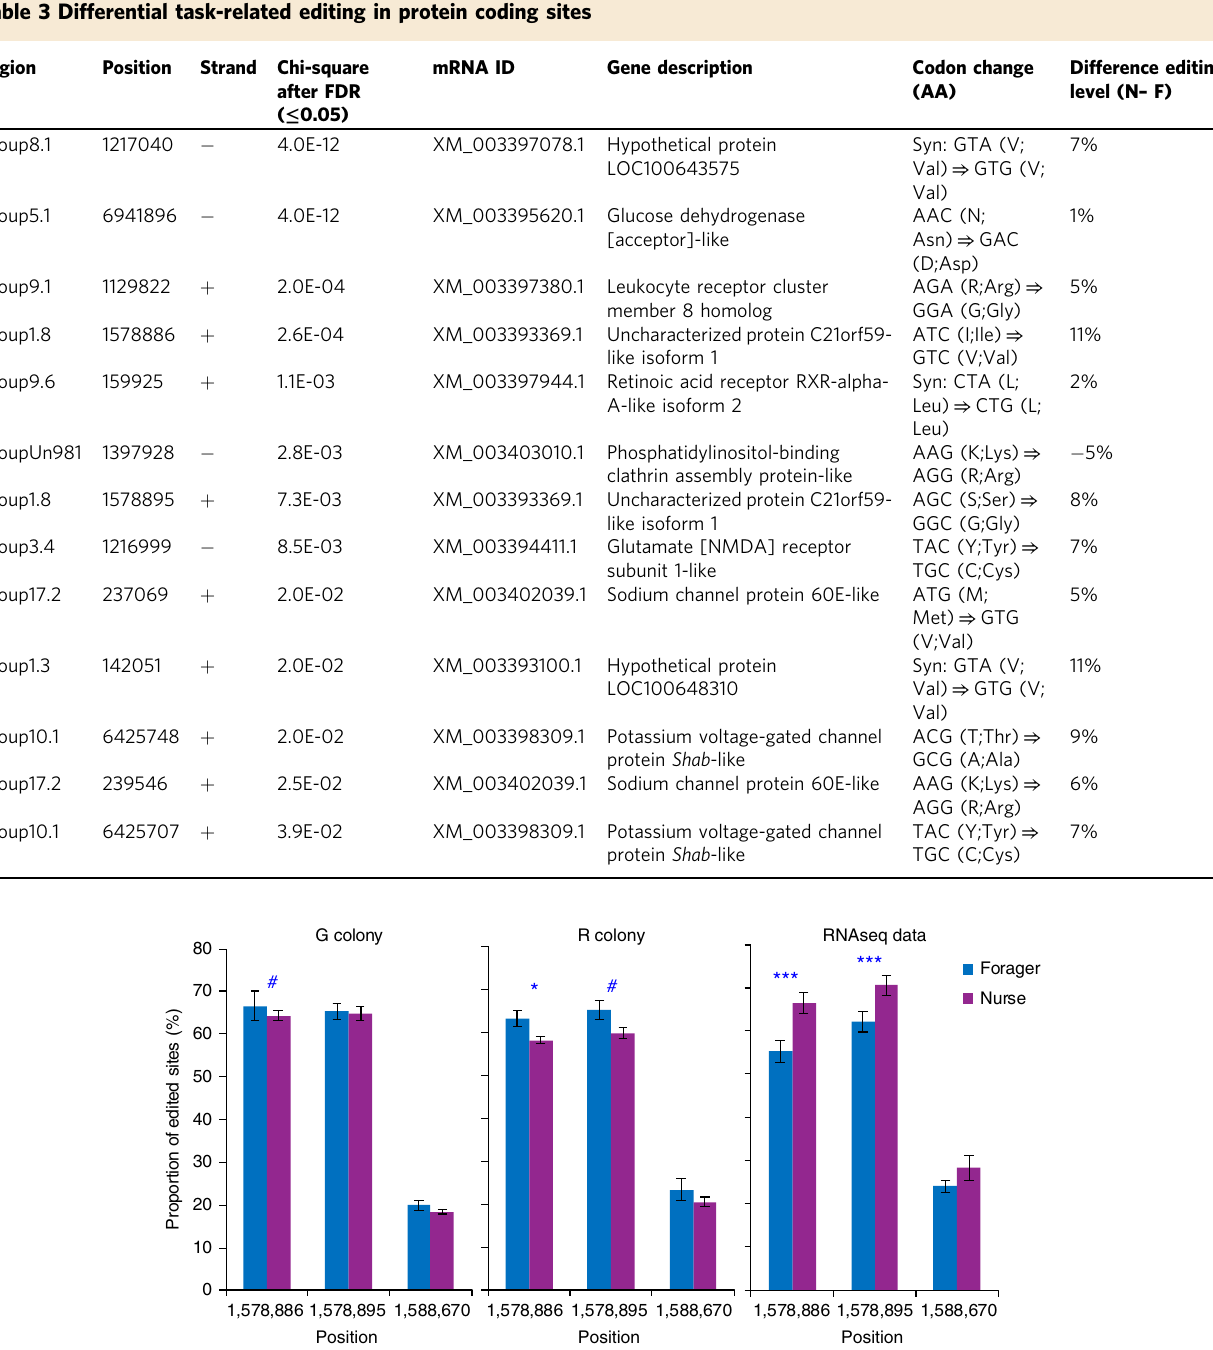
Fig. 5 TipE-like transcripts differentially edited in nurse and forager bumblebees. The left and median panels show quanti fi cations of Sanger sequencing for bees from two different fi eld foraging colonies (G and R, respectively). The rightmost panel summarizes the results for the same sites based on MuTect analyses from bees from a different fi eld foraging colony. The numbers on the x -axis denote the position of the editing site at Group1.8. The blue marking above the bars summarize the statistical analyses (Mann – Whitney test, # P = 0.07, * P < 0.05, *** P < 0.001), values presented as mean ± SE. Note that overall editing levels for all three sites were similar for the three analyses. Source data are provided as a Source Data fi